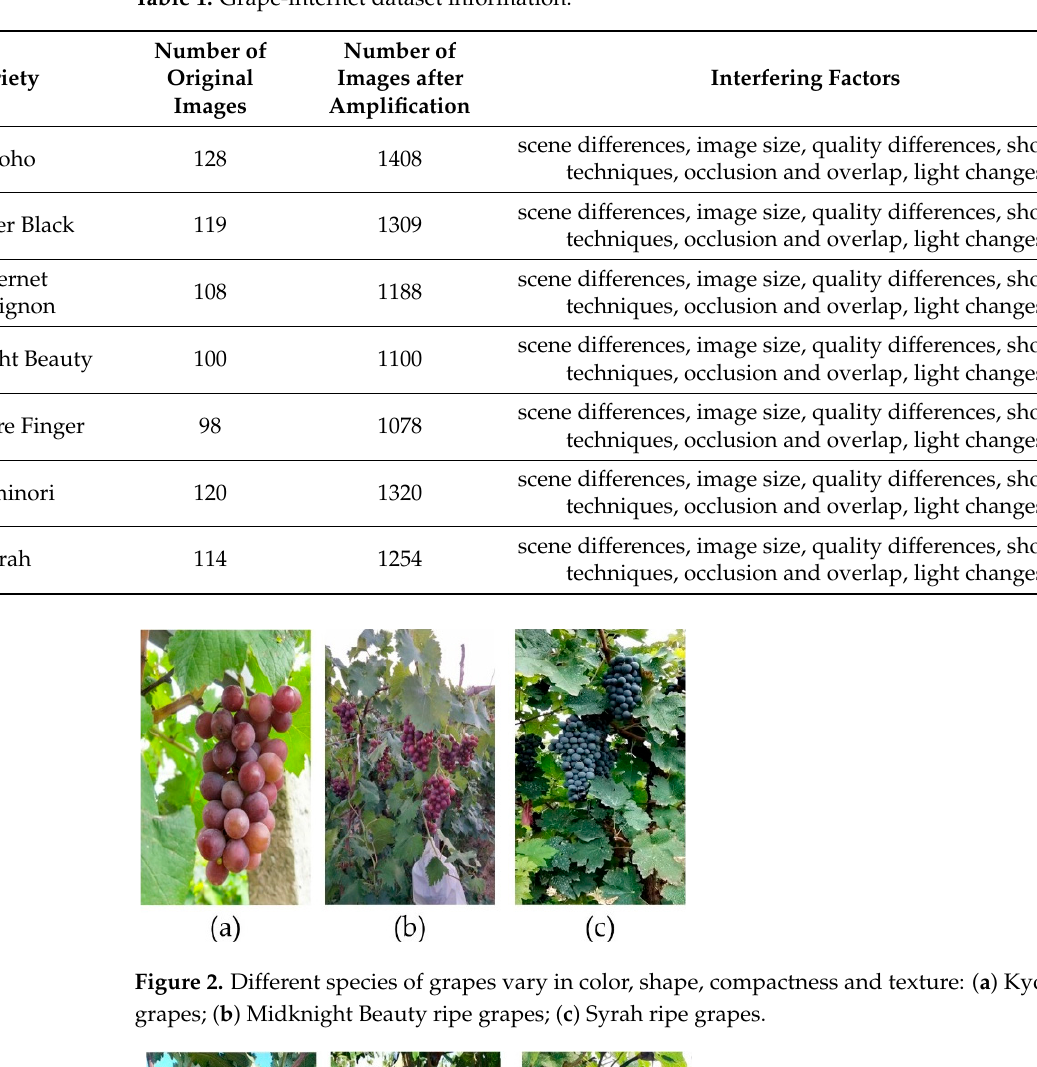
Figure 4. Diversity of shooting angles and light: ( a ) Flat angle; ( b ) Elevation angle; ( c ) Depression angle; ( d ) Sidelight; ( e ) Backlight; ( f ) Front light. 2.2. Grape Cluster Detection Based on YOLOv5s Deep Learning Algorithm 2.2.1. YOLOv5s Network Frame Since the experimental images in this study were all derived from the internet, there were significant differences between the images in variety, shooting background, resolu- tion, illumination and occlusion. To avoid the adverse effects of these differences on the target detection algorithm, and to improve the robustness of the grape detection algo- rithm, the YOLOv5s deep learning algorithm was used for grape target detection in this work. The YOLO (You Only Look Once) network [23] is a classic one-stage structure target detection algorithm. The location and classification of detected objects can be predicted in one stage, which can significantly improve detection speed [24]. YOLOv5 is a member of the YOLO family, and the algorithm structure has inherited, optimized and improved the previous modules, such as the Center and Scale Prediction (CSP) structure, the Spatial Pyramid Pooling (SPP) structure and the Feature Pyramid Networks (FPN) + Path Aggre- gation Network (PAN) structure in YOLOv4. It has also added an adaptive image scaling operation at the input end. Additionally, the Focus structure was added to the baseline network, which greatly improved both the detection speed and precision. YOLOv5s, one of the four network structures of YOLOv5 [25], possesses a pretrained speed of 156.25 fps and a mAP of 56.0%, which endows it with fast network inference, high detection precision and good real-time performance. Thus, YOLOv5s is suitable for